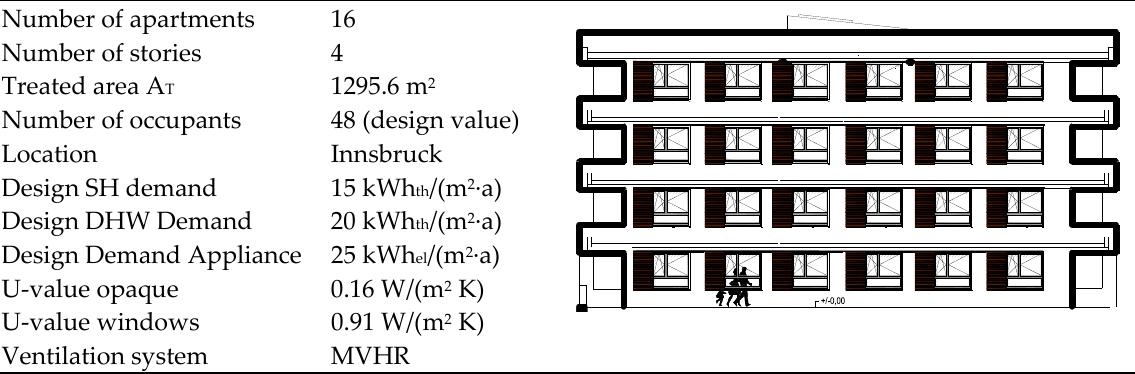
Figure 6. Sketch of the reference building, multi-apartment building with 4 stories and 16 flats (Neue Heimat Tirol).